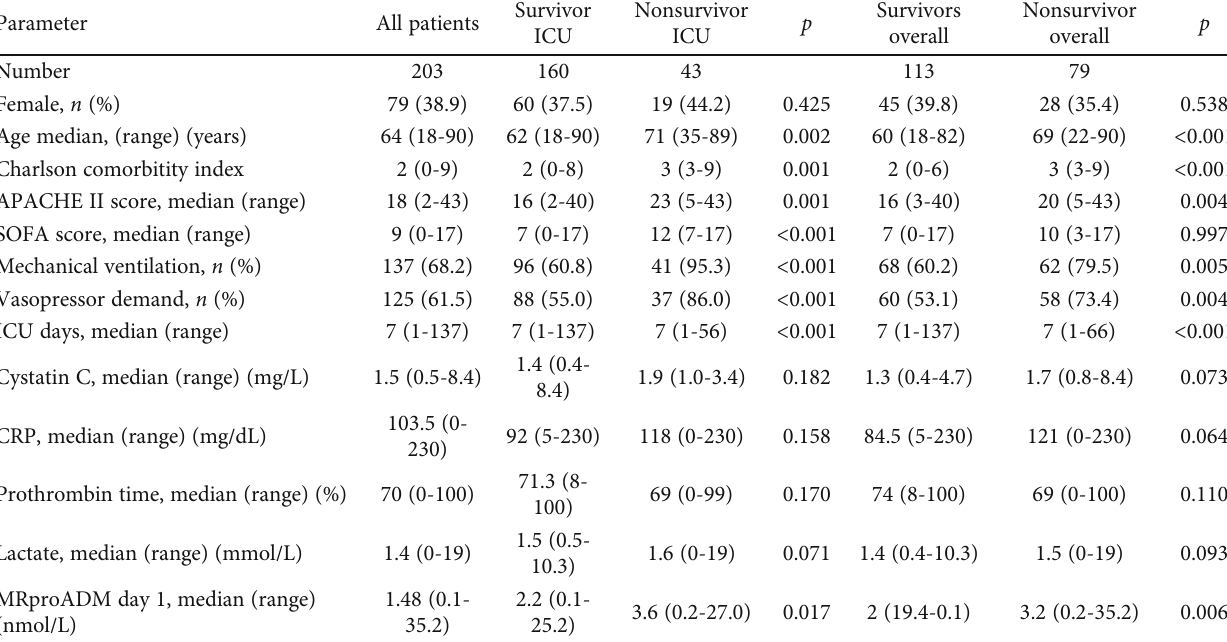
Table 4: Patient characteristics and comparison between survivors and nonsurvivors (ICU and overall survival).